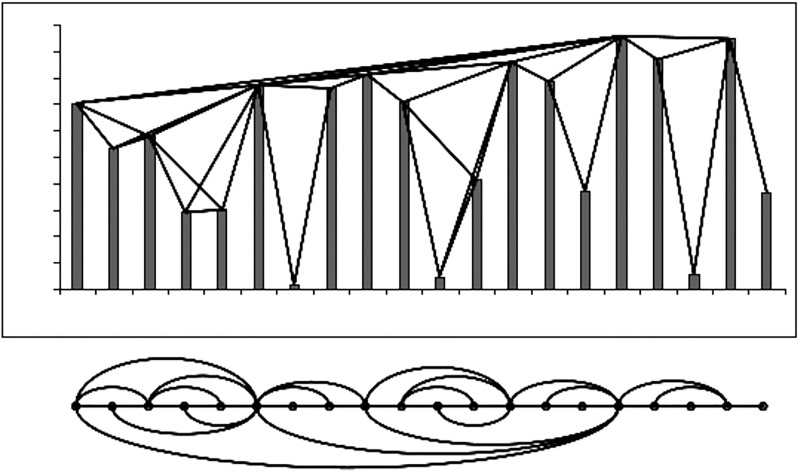
Construction of a network using the NVA.